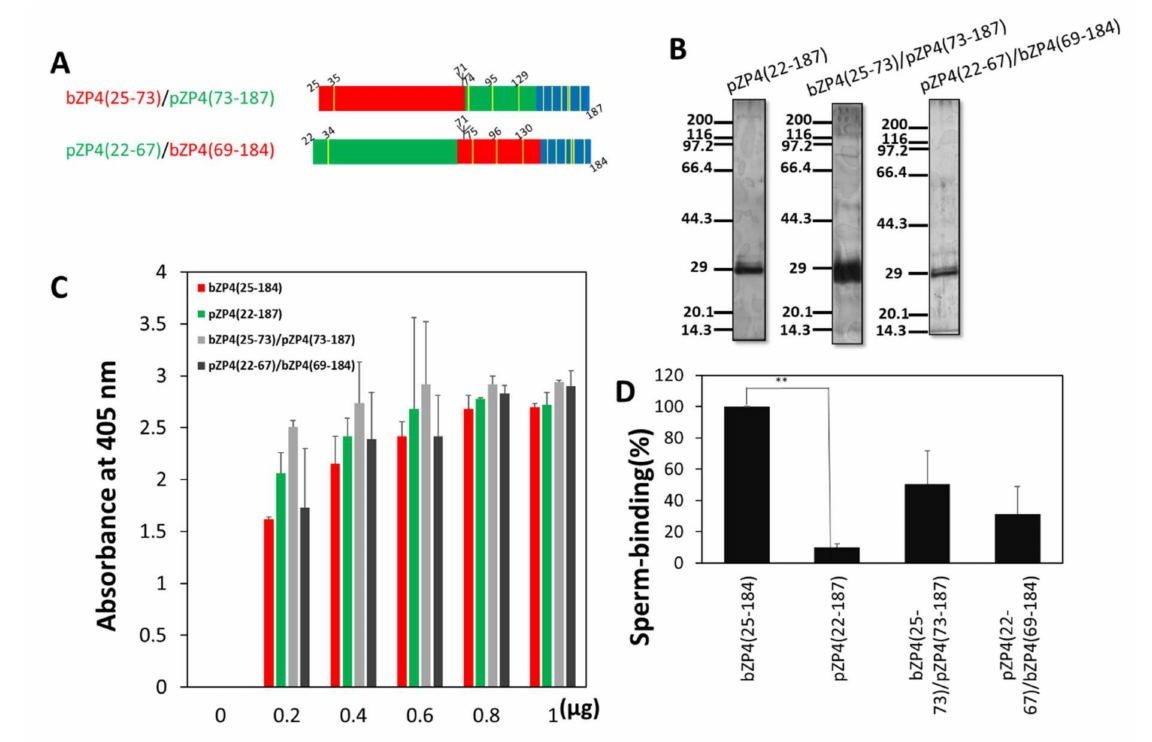
Figure 2. Two regions in bZP4(25–184) are involved in its sperm-binding activity. ( A ) Schematic diagrams of chimeric proteins between the N-terminal ZP-N1 domains of bZP4 (red) and porcine (p)ZP4 (green). Trefoil domains are shown in blue and Cys residues are in yellow bars. ( B ) SDS- PAGE of pZP4(22–187) and bovine/porcine and porcine/bovine chimeric fragments. pZP4(22–187), bZP4(25–73)/pZP4(73–197), and pZP4(22–67)/bZP4(69–184) were expressed in Sf9 cells and purified by TALON resin specific to His-tag. Gels were silver-stained. Molecular mass standards (kDa) are indicated on the left side of each panel. ( C ) Adsorption of bZP4(25–184) (red), pZP4(22–187) (green), bZP4(25–73)/pZP4(73–187) (light gray) and pZP4(22–67)/bZP4(69–184) (dark gray) to plastic wells. The amount of each recombinant ZP4 protein added to one plastic well is indicated under each group of bars. The amounts of proteins necessary for adsorption saturation were examined by detecting the adsorbed proteins with an antibody specific to the N-terminal His-tag. The experiment was performed three times and the average ± standard deviation (SD) of absorbance at 405 nm is shown. ( D ) Sperm- binding activity of the four recombinant ZP4 proteins shown in ( C ). Plastic wells were coated with each of the proteins (0.8 µ g for each protein). The number of sperm bound to the wells coated with bZP4(25–184) varied from 33 to 65 but was designated as 100% for each experiment. Assays were repeated five times. Data are presented as the mean ± SD, with statistical significance between bZP4(25–184) and pZP4(22–187) indicated as p < 0.01 (**) on the line connecting the two bars.